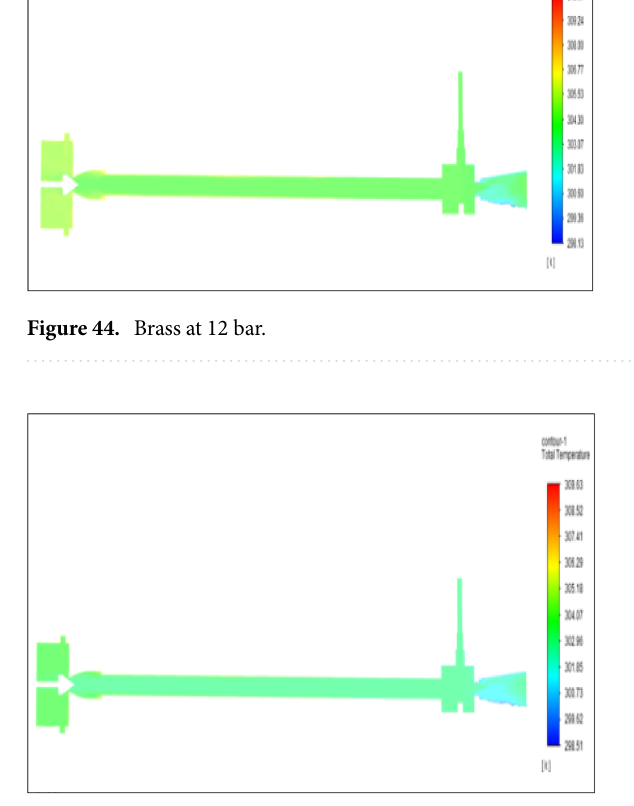
Figure 45. PVC at 12 bar.